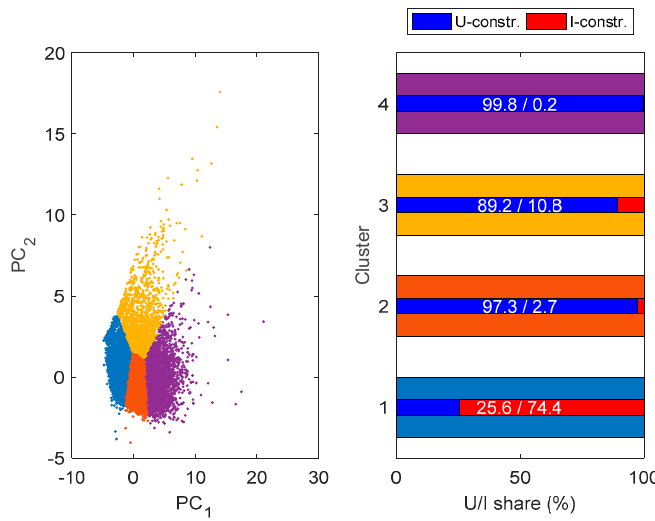
Figure 13. External validation of the clusters—cluster vs. classes.